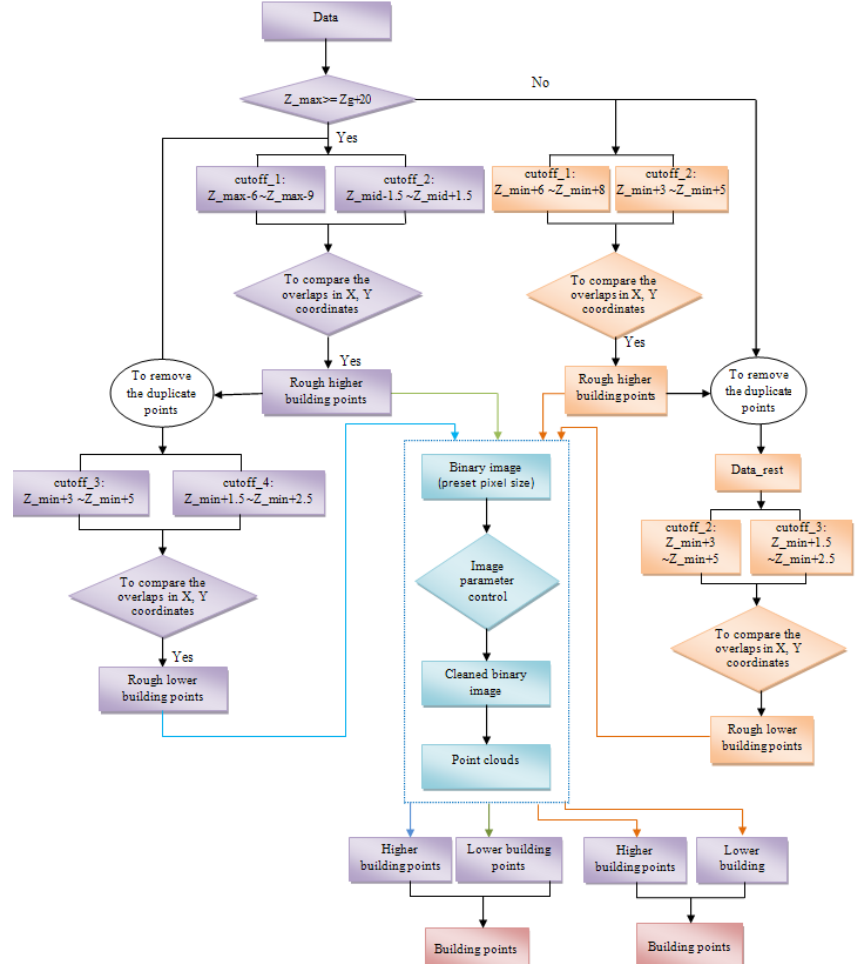
Figure 8. The procedure in building point